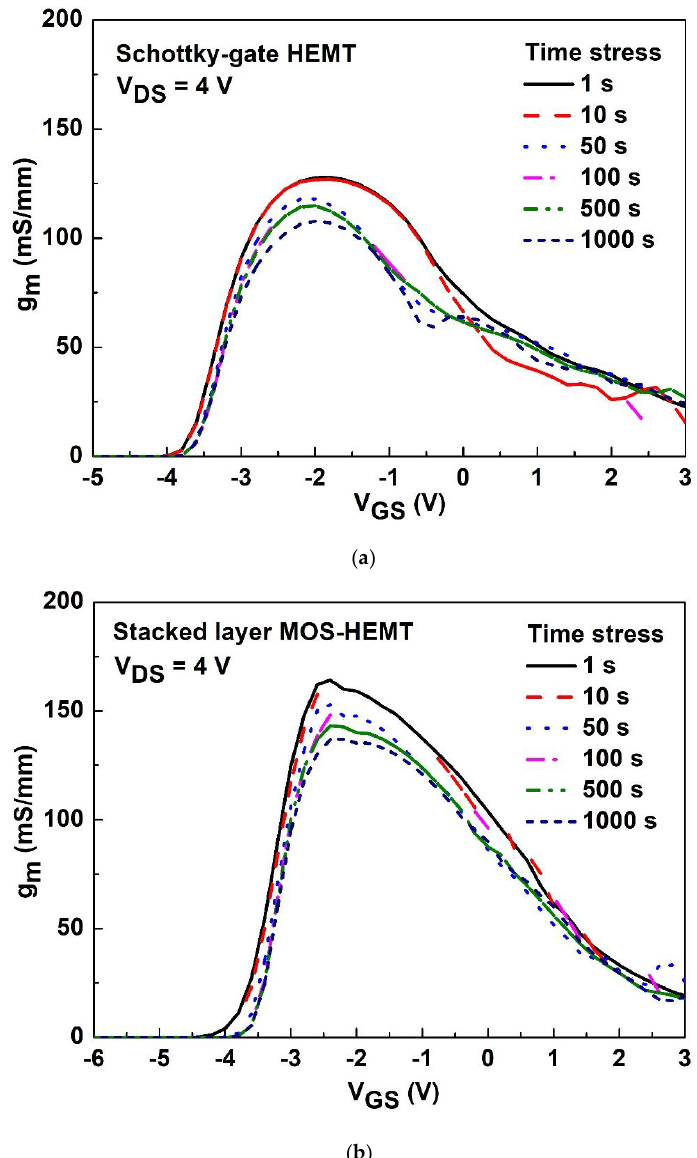
Figure 9. The g m after stress at V GS of 1 V and V DS of 4 V with different stress time ranged from 1 s to 1000 s at room temperature for ( a ) the Schottky-gate HEMT and ( b ) the stacked layer MOS-HEMT.